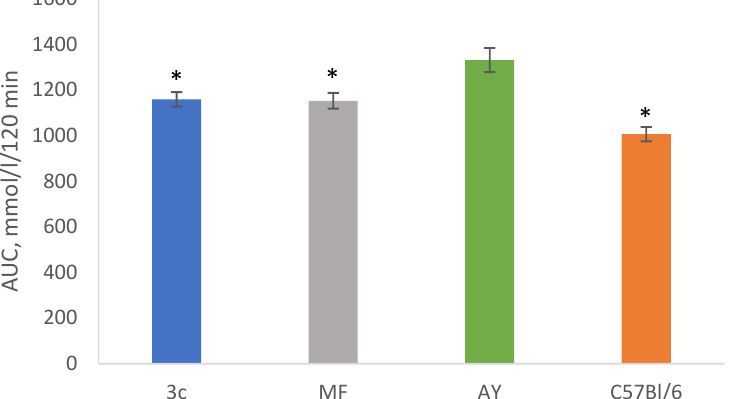
Figure 5. Area under the glycemic curve calculated according to the OGTT data after 4 weeks of AY mice treatment by compound 3c at a dose of 15 mg/kg and MF at a dose of 250 mg/kg. * p < 0.05 as compared to AY mice.